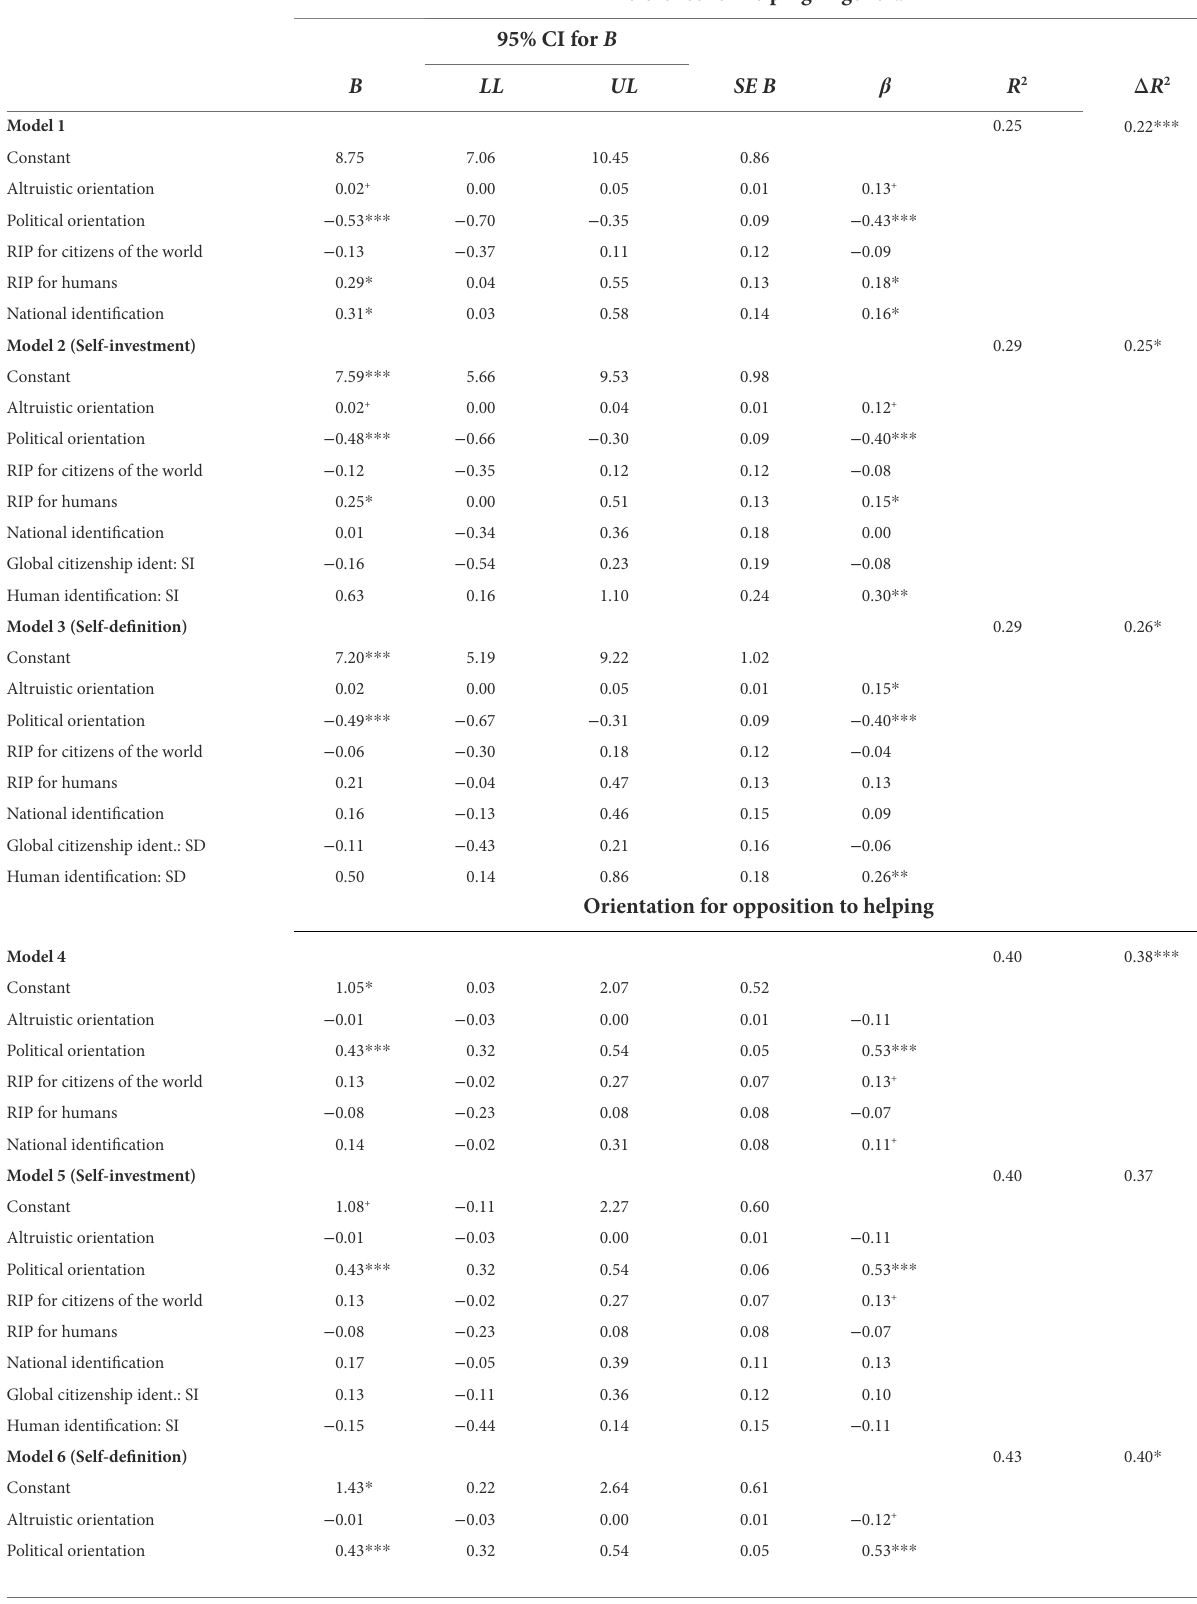
TABLE 2 Hierarchical multiple regression results for helping preferences and orientations regardless of the type of help. Preference for helping in